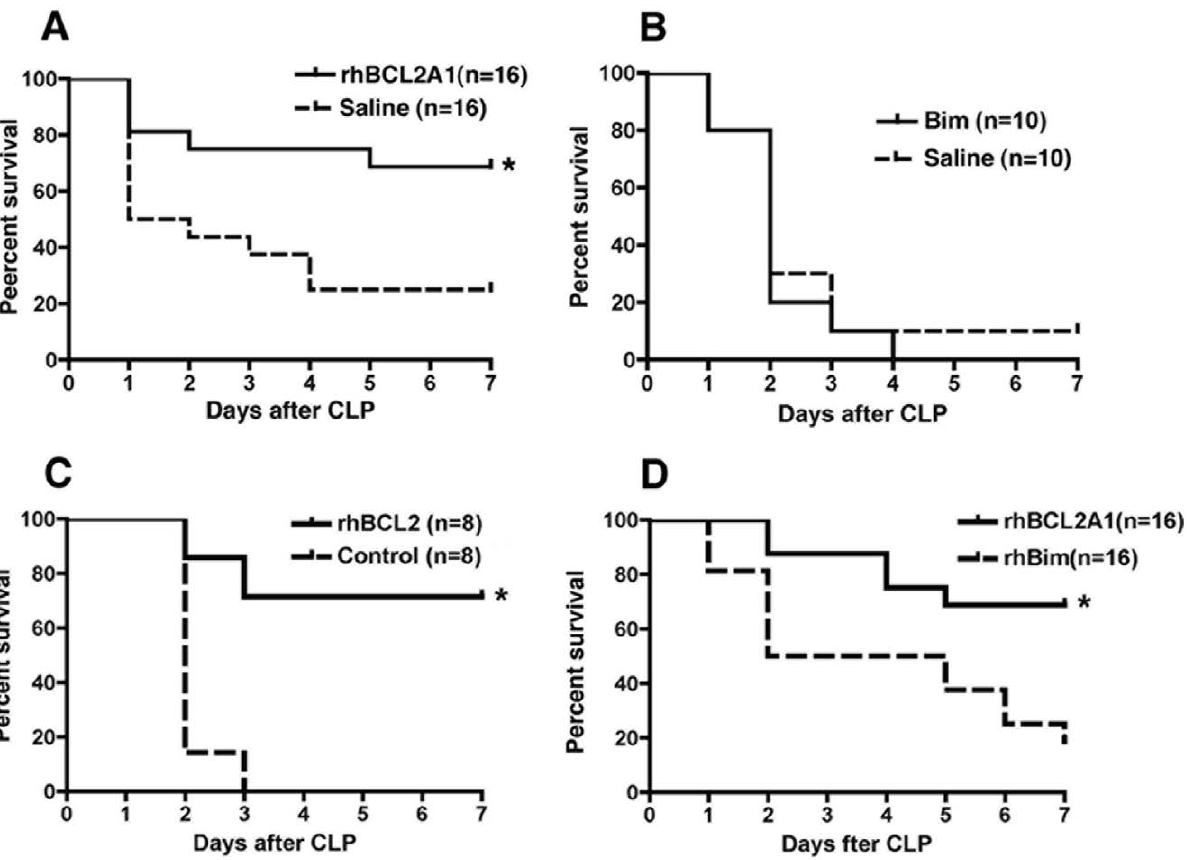
Figure 1. Treatment with rhBCL2A1 or rhBCL2 protein improves survival following CLP. Mice were subjected to CLP and followed for 7 days. An assessment table was used as a surrogate marker for death and the animals euthanized according to approved criteria. (A) Mice were treated by i.p. injection of 1 m g rhBCL2A1 or saline 18 hours prior to CLP and then every 12 hours for 3 consecutive days. Treatment with rhBCL2A1 conferred significant protection compared to saline. *p=0.012. (B) Mice were treated by i.p. injection of 1 m g rhBim or saline 18 hours prior to CLP and then